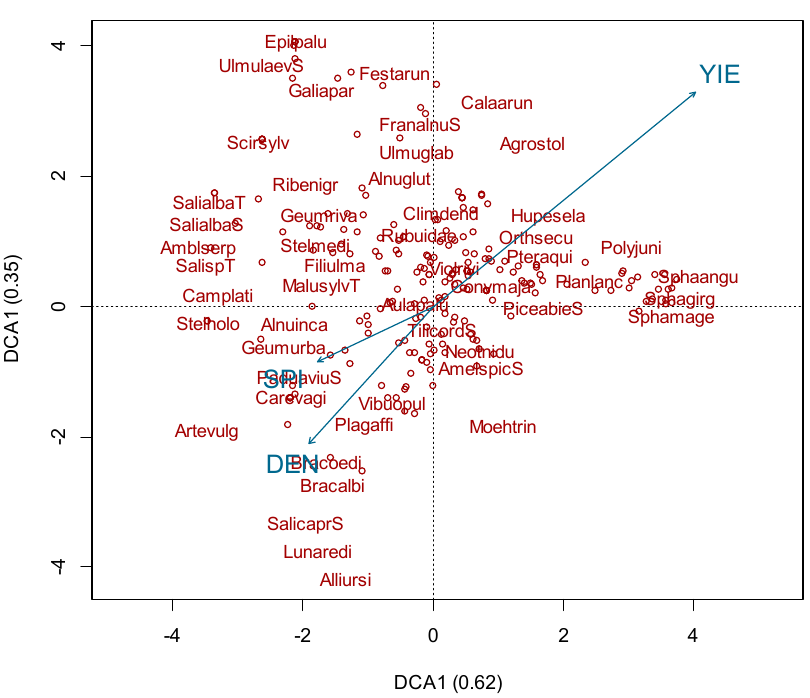
Figure 2. Grouping of understory vegetation species: results of detrended correspondence analysis. Analyzed factors: density (DEN), stream power index (SPI), total yeld (YIE). Letters “T” and “S” at the end of words represent the tree or shrub layer that they were classified into.